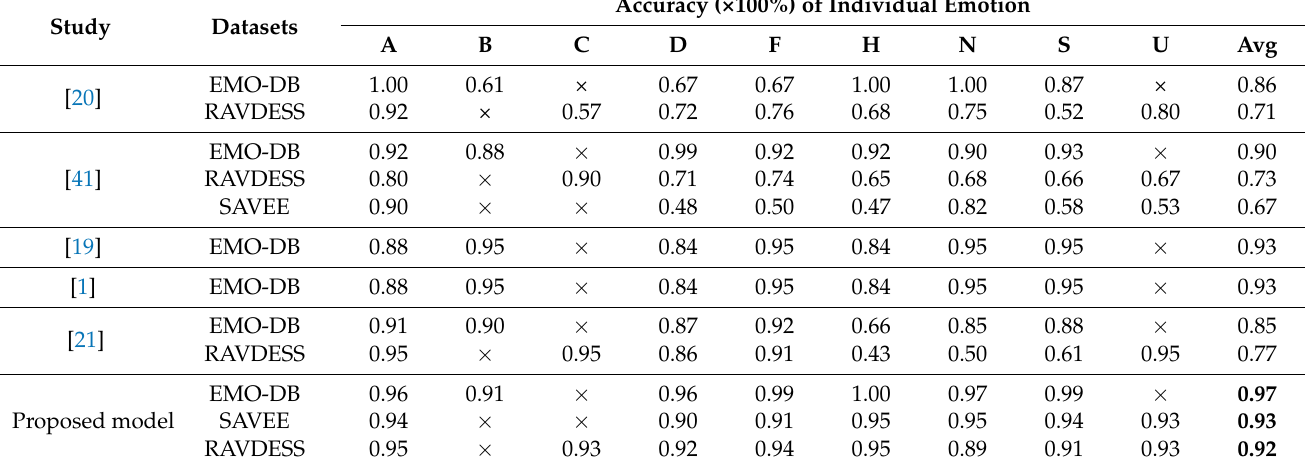
Table 5. Comparative analysis of the SER method and the baseline methods utilizing the EMO-DB, SAVEE, and RAVDESS